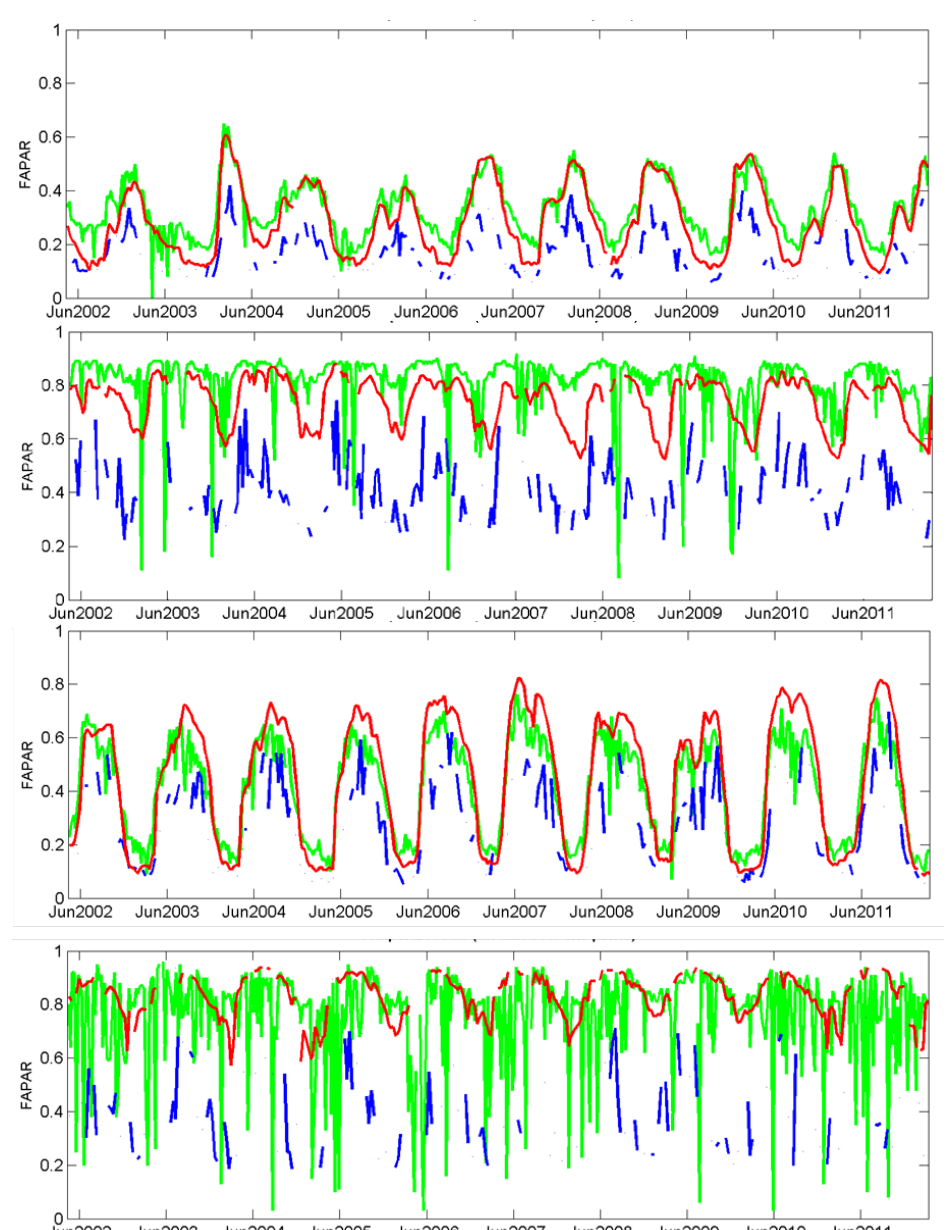
Figure 5. Typical temporal profiles over a selection of BELMANIP2.1 sites for GEOV1 (red), MGVIo (blue) and MODC5 (green): ( a ) Non forest (site #5, 34.02°S, 65.63°W); ( b ) Needleleaf forest (site #65, 30.28°N, 83.85°W); ( c ) Deciduous broadleaf forest (site #165, 5.98°N,31.18°E); ( d ) Evergreen broadleaf forest (site #320, 24.54°N, 121.2°E). Values are computed as the median of 3 × 3 pixels centered on each site at their initial temporal